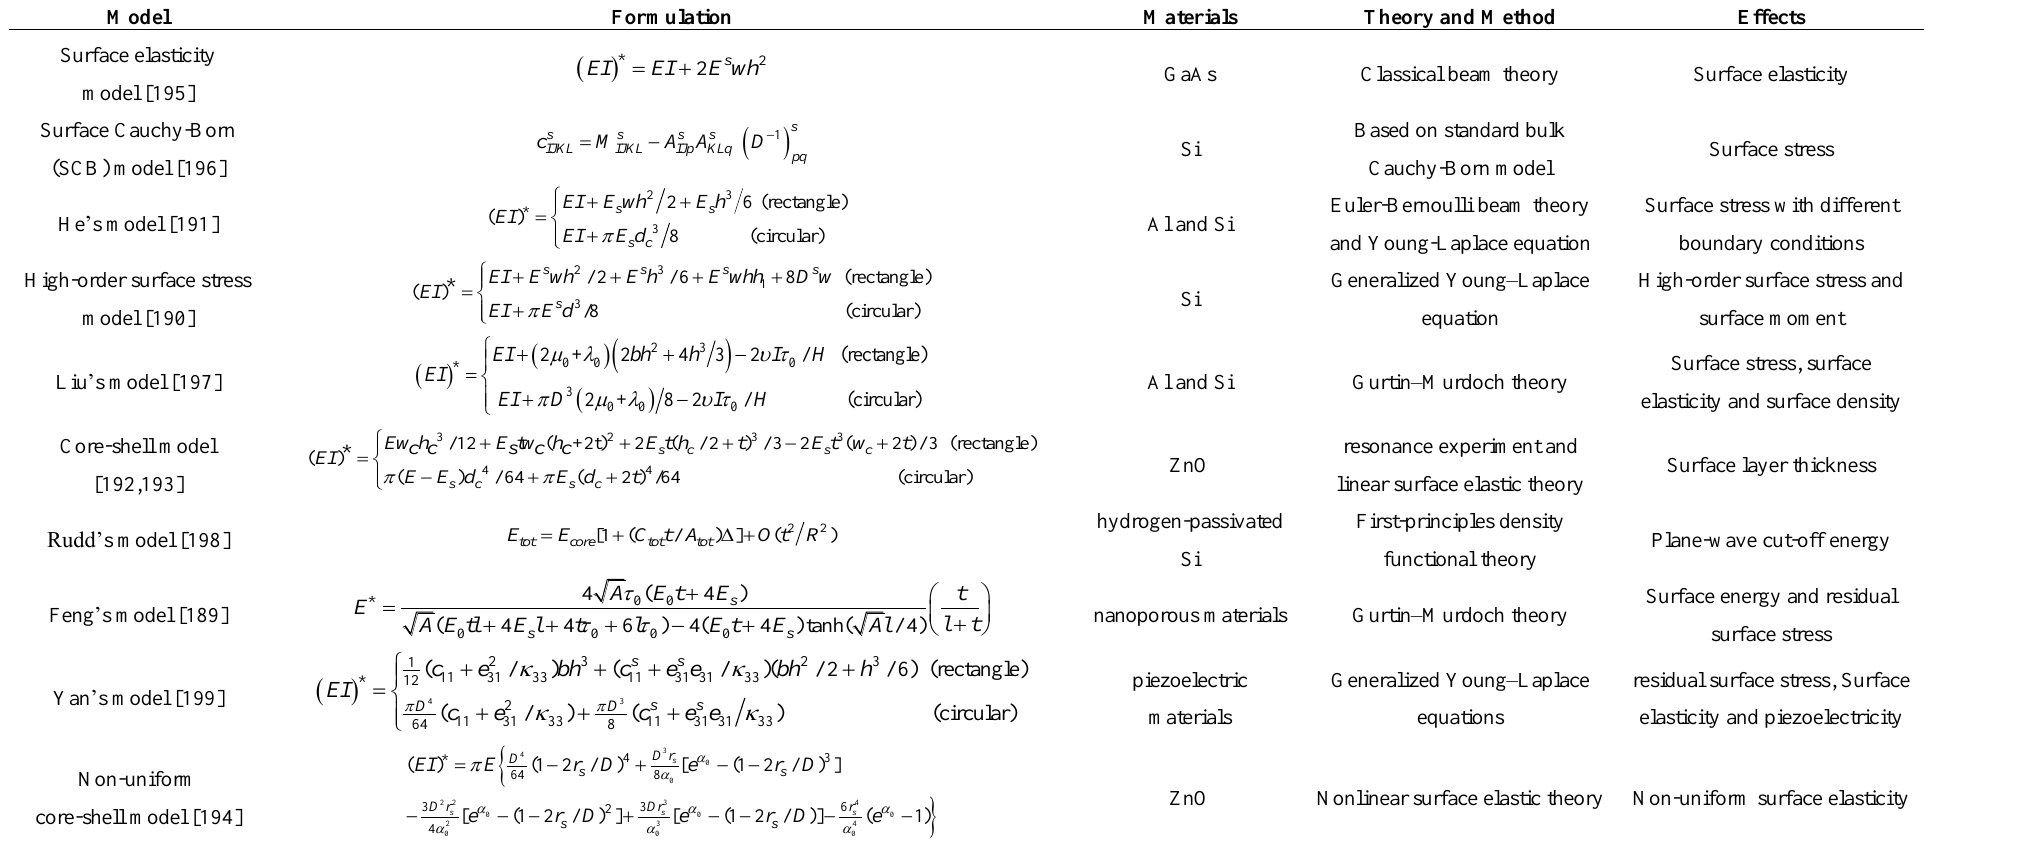
Table 5. Comparison of some surface elastic models for surface Young’s modulus of nanowires resonators (The relative parameter descriptions can be seen in the